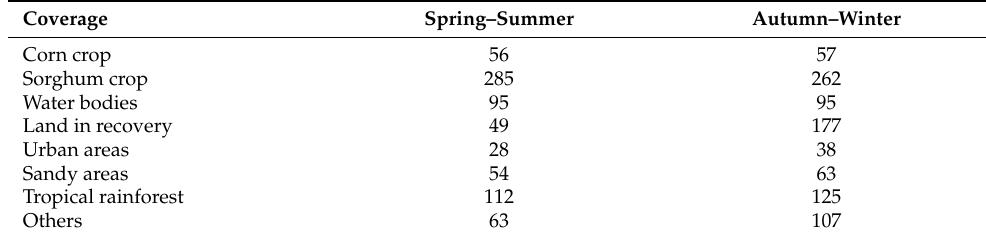
Table 4. Collection of sample points for test.